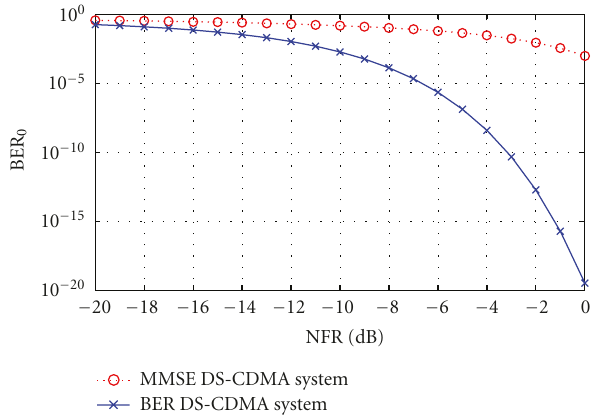
Figure 7: BER 0 versus NFR performances of the MMSE DS-CDMA system ( ··· ◦ ··· ) and the proposed minimum BER DS-CDMA system ( − × − ), when l = 0, M = 7, L = 5, N = 5, and E b / N 0 = 20 dB in all cases.